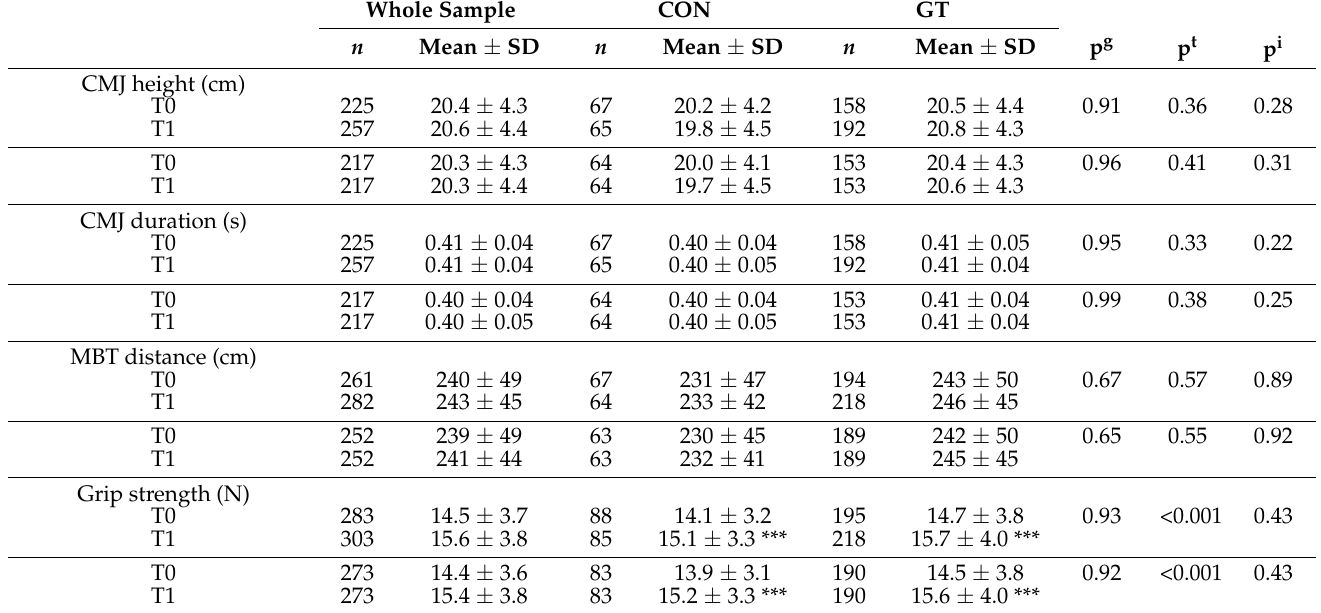
Table 1. Physical fitness, physical activity level, sedentary time, and perceived physical fitness at baseline (T0) and one month later (T1) according to control (CON) and Globe Trotter (GT)